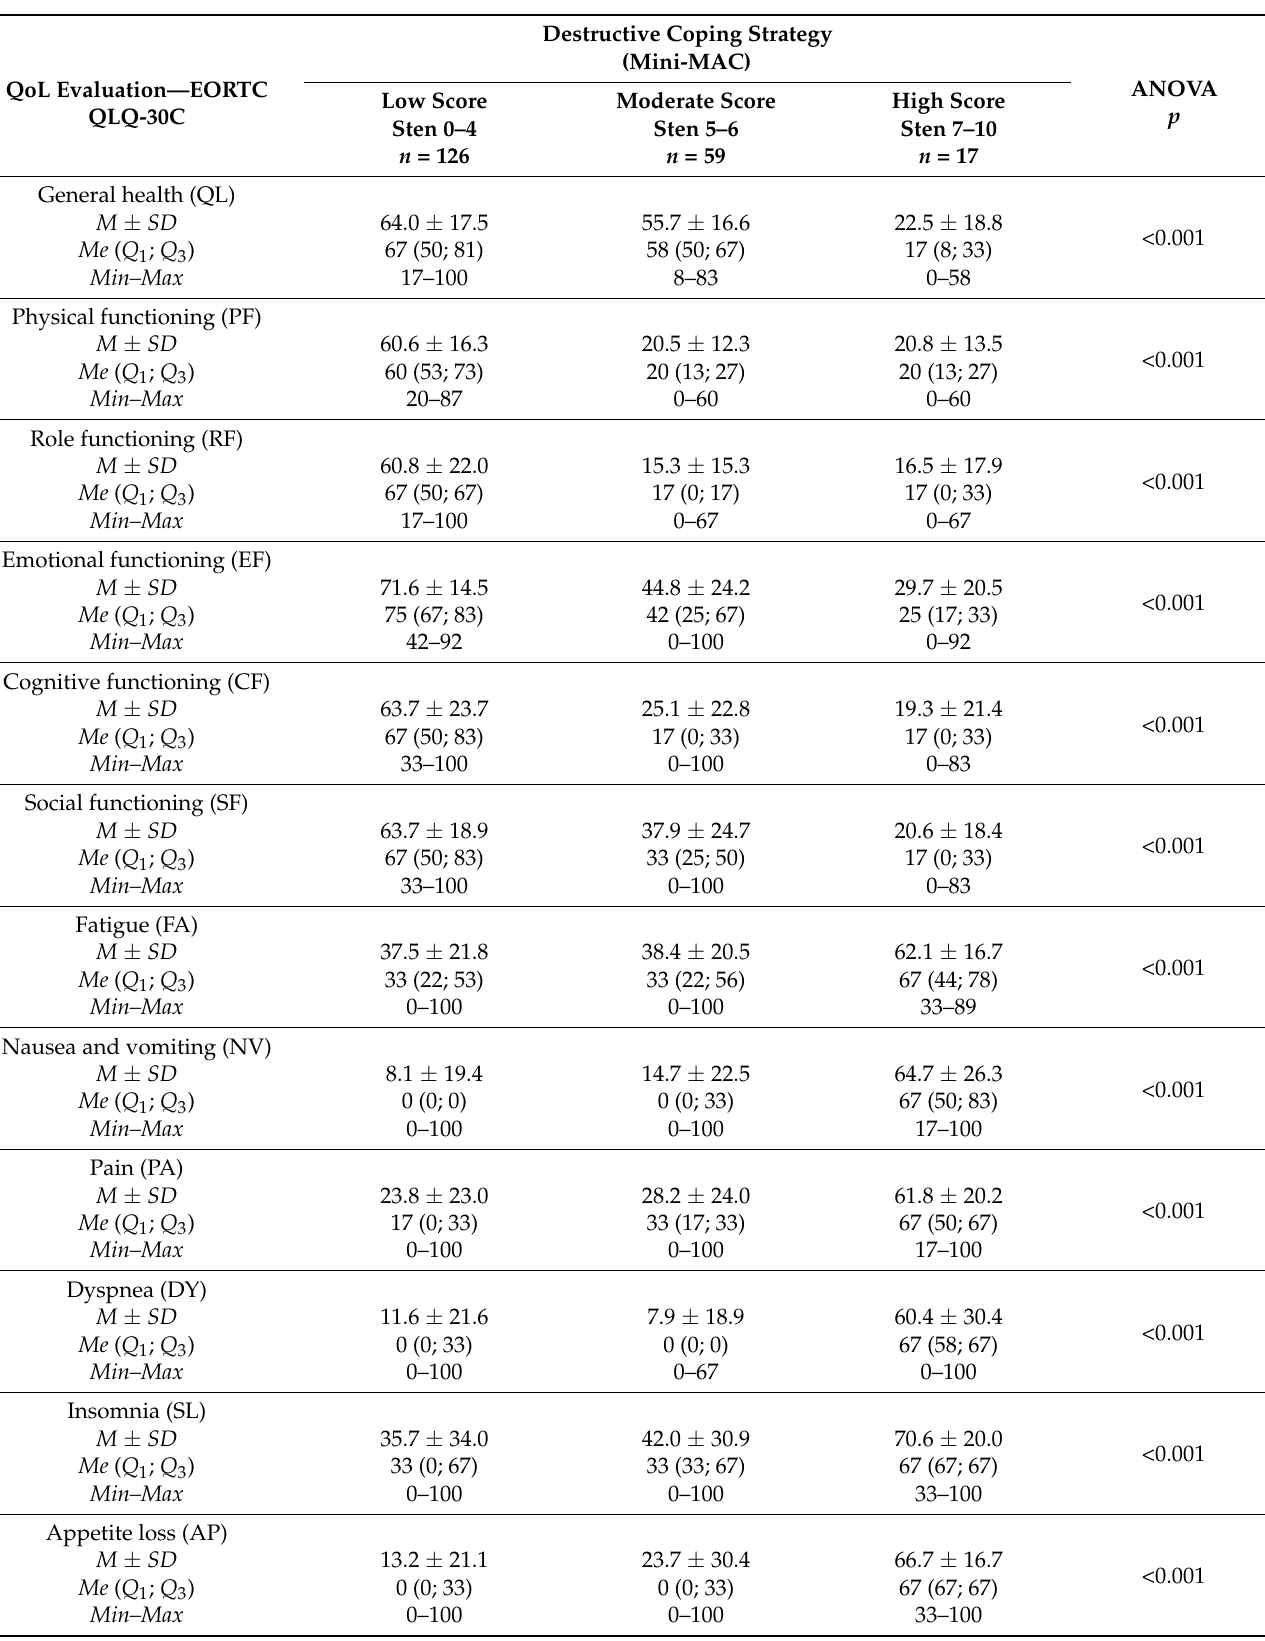
Table 7. Quality of life (EORTC QLQ-30C scores) in patients differing in terms of scores for the destructive coping strategy (Mini-MAC), with analysis of variance